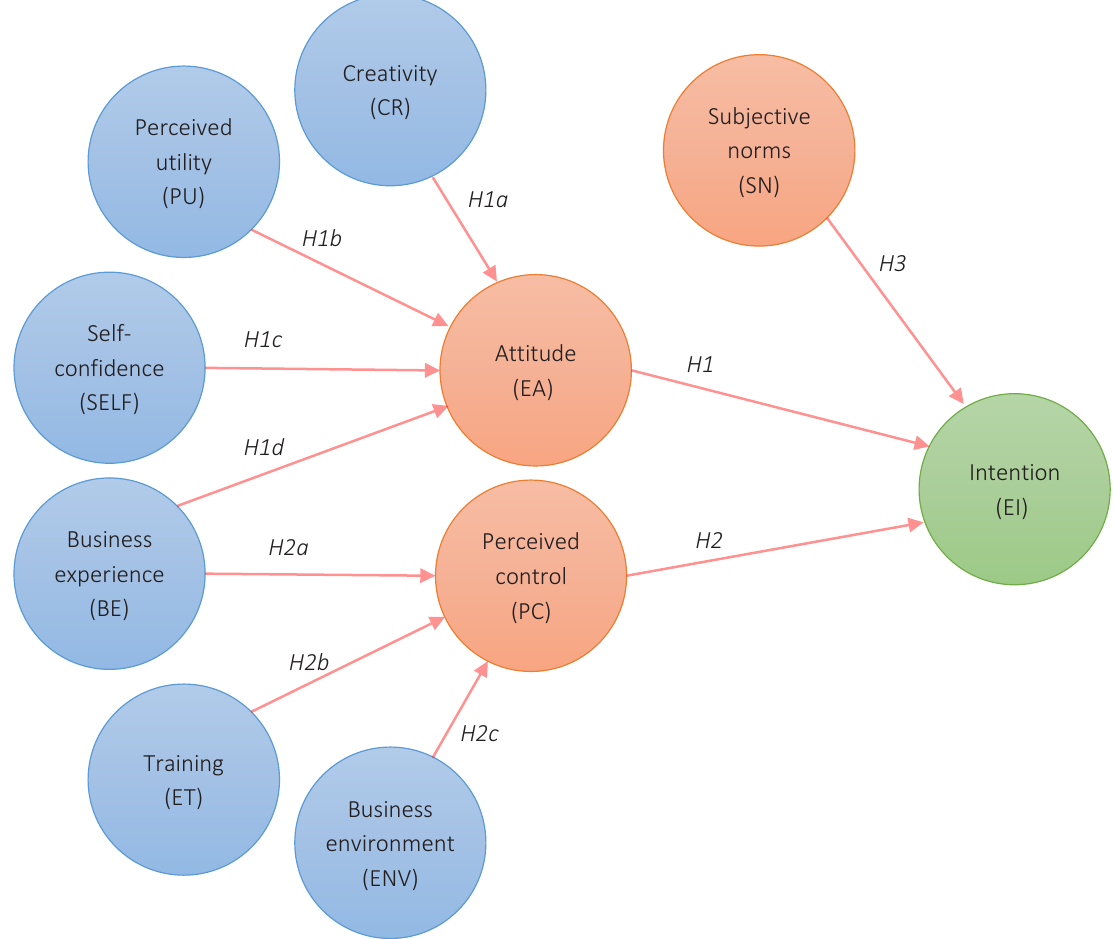
Figure 1. Hypothetical